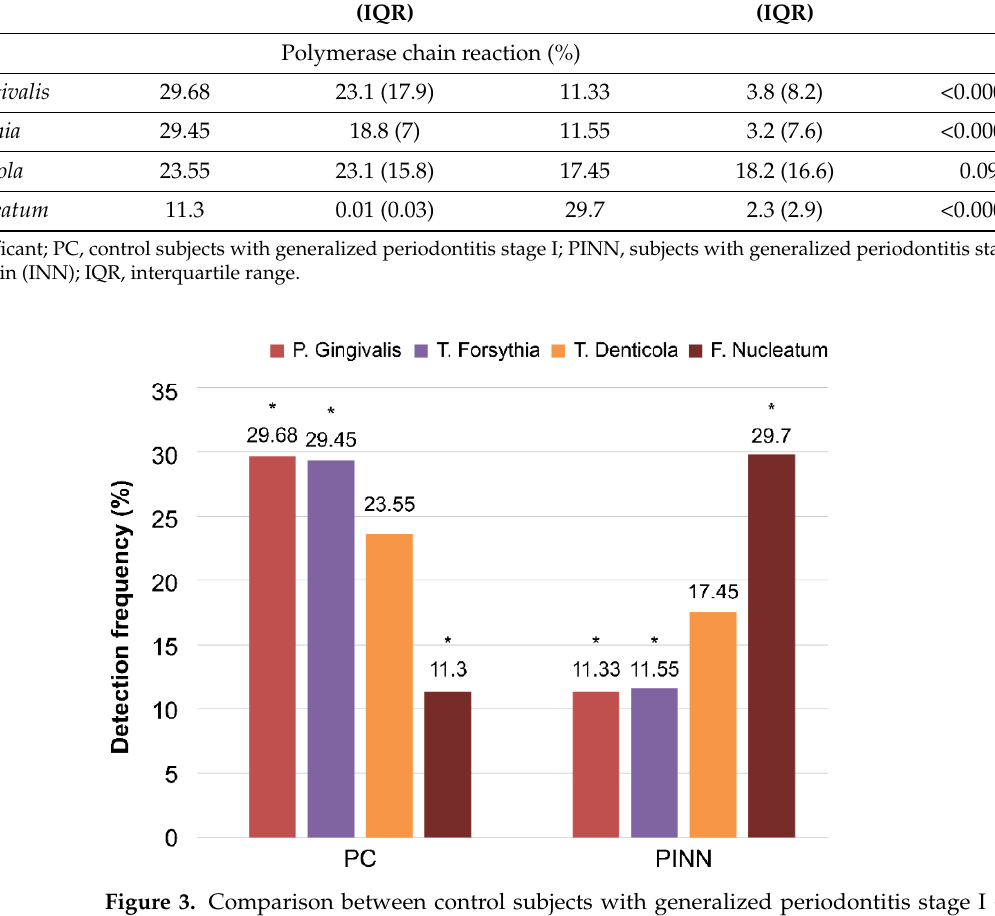
Table 4. Comparison of mean ranks of outcome variables between the periodontitis groups.